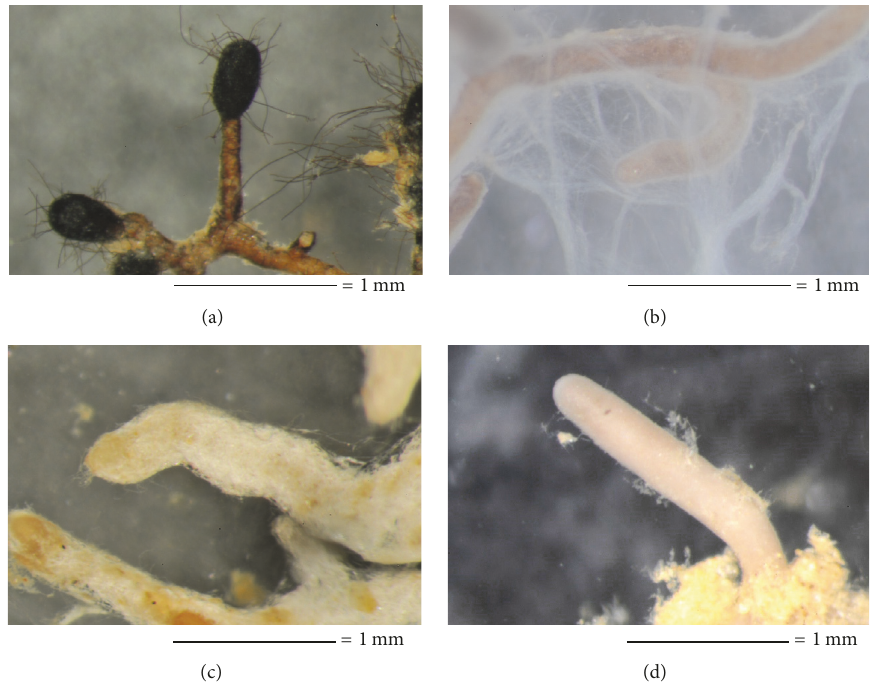
Figure 1: Photographed (45x) ECM morphotypes sampled from American chestnut root tips from a reclaimed mine site in Dresden OH, USA. Panels display the following that were matched to vouchered genera sequences in GenBank: Panel (a) Cenococcum sp. on C. dentata , Panel (b) Cortinarius sp. on hybrid BC 1 F 3 , Panel (c) Scleroderma sp. on hybrid BC 2 F 3 , and Panel (d) Russula sp. on C. dentata. Bar = 1